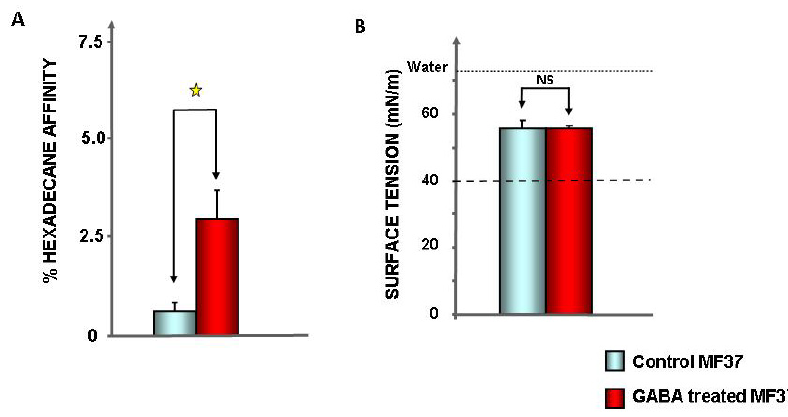
Figure 5. Effect of GABA (10 − 5 M) on the global surface polarity ( A ) and biosurfactant production ( B ) of P. fluorescens MF37. The surface polarity was determined by measurement of the affinity of bacteria to hexadecane. The biosurfactant production was estimated by measurement of the surface tension of rinsing solutions of bacterial colonies grown on solid agar medium. (NS: non-significant;  : p < 0.05).